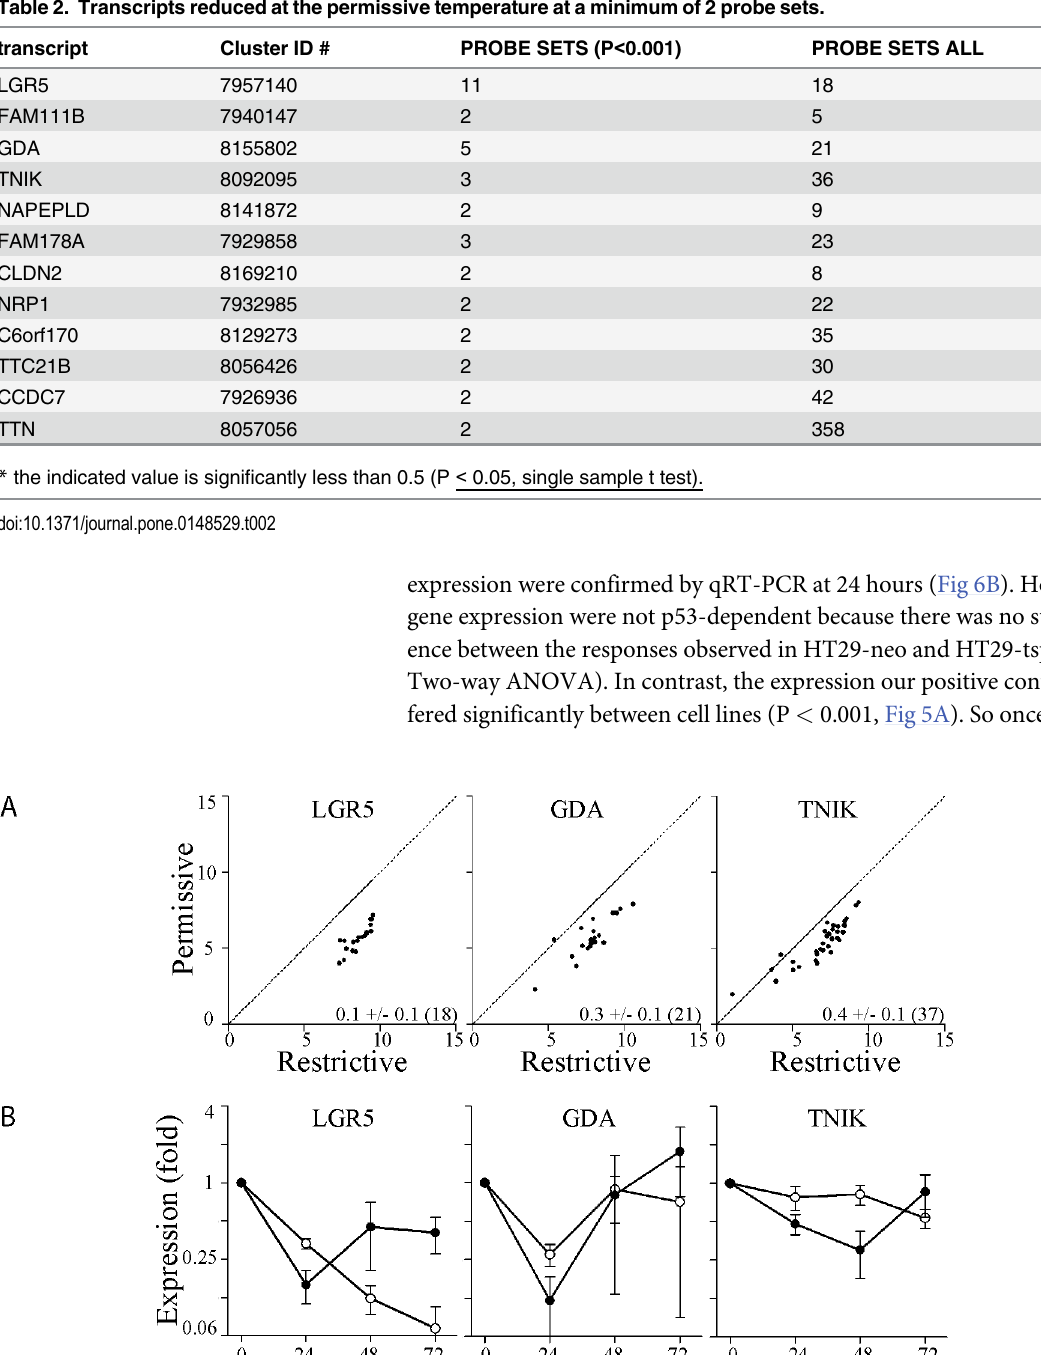
Fig 6. Transcripts downregulated at the permissive temperature were not strictly p53-dependent. (A) Signal intensity of individual probesets from microarray analysis at the restrictive temperature (X axis) is compared to the signal intensity at the permissive temperature (y axis). The mean fold change ( ± SEM and n) for each transcript is inset in the corresponding panel. RNA samples were collected at 16h following temperature shift. (B) Total RNA was isolated from control (open symbols) and HT29tsp53 (closed symbols) cells at the indicated time and the expression of a variety of mRNAs was determined. Expression in each sample was normalized to the expression of the same transcript in samples collected immediately before the temperature shift. (Each point represents the mean ( ± SEM) determined from a minimum of 3 independent